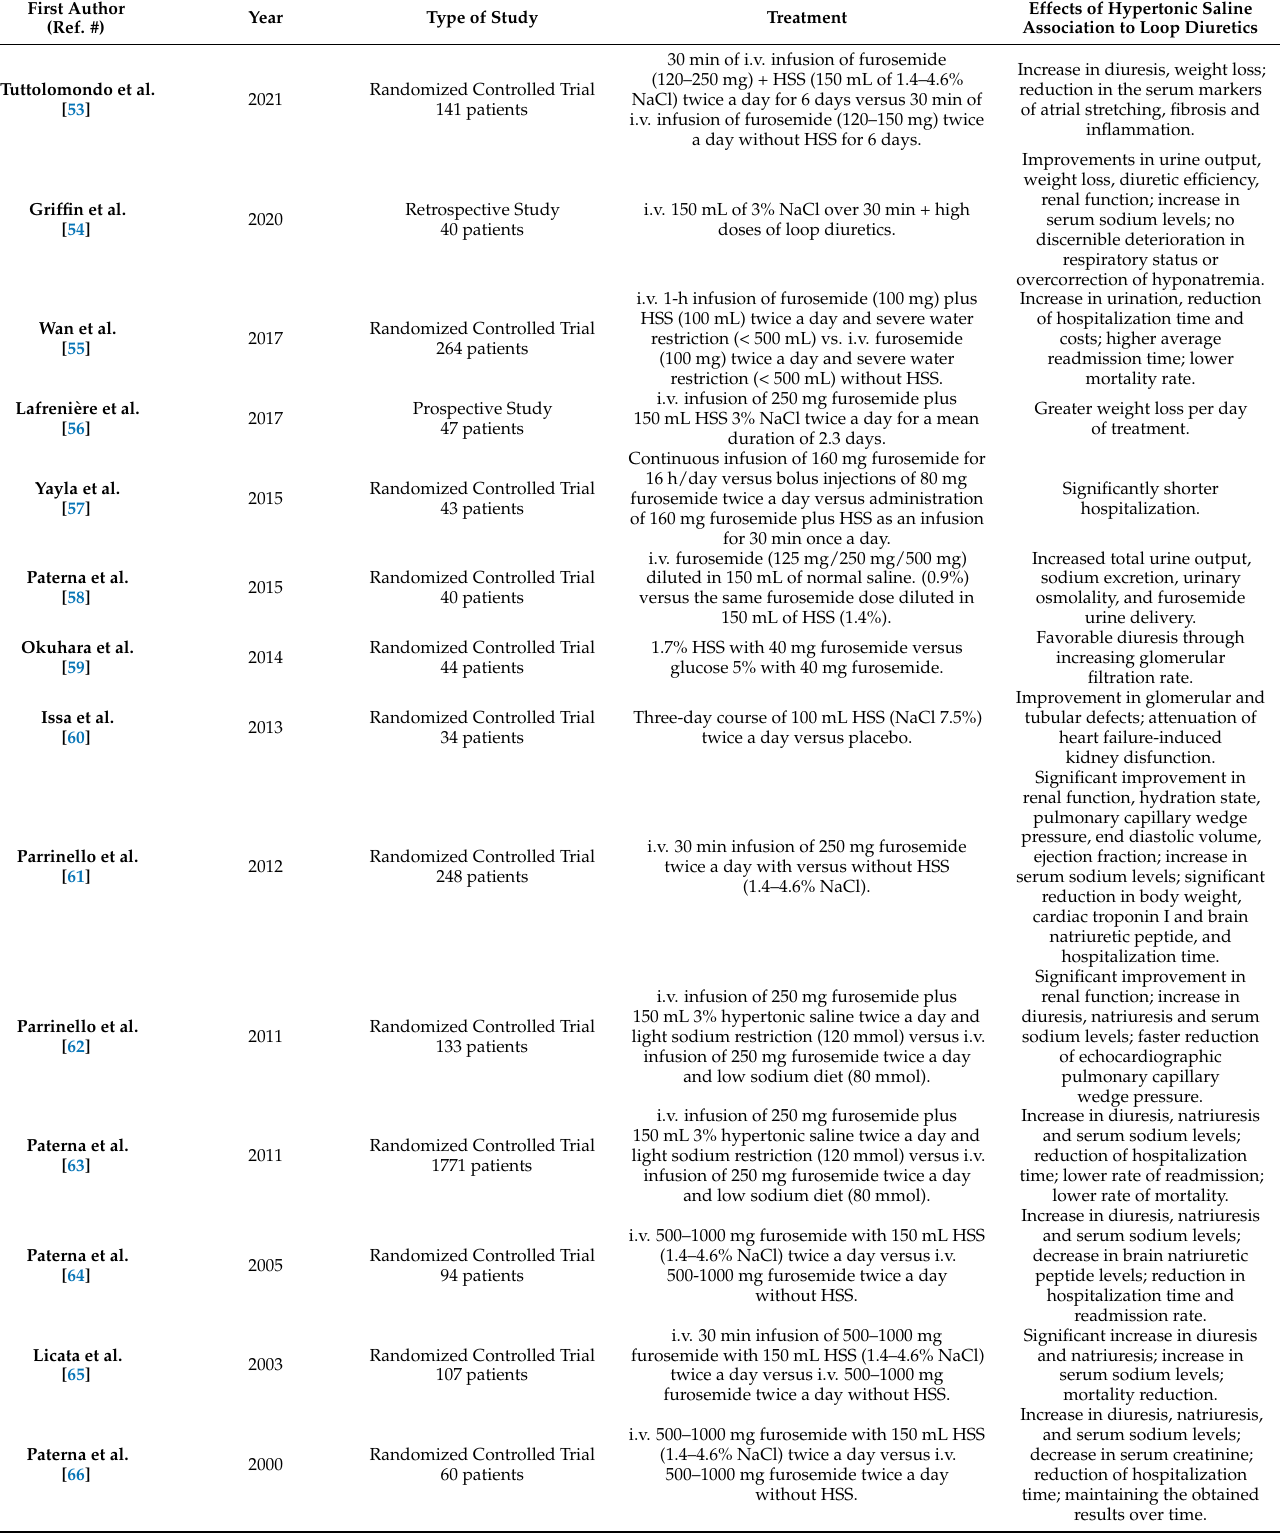
Table 2. Studies on hypertonic saline in patients with acute decompensated heart